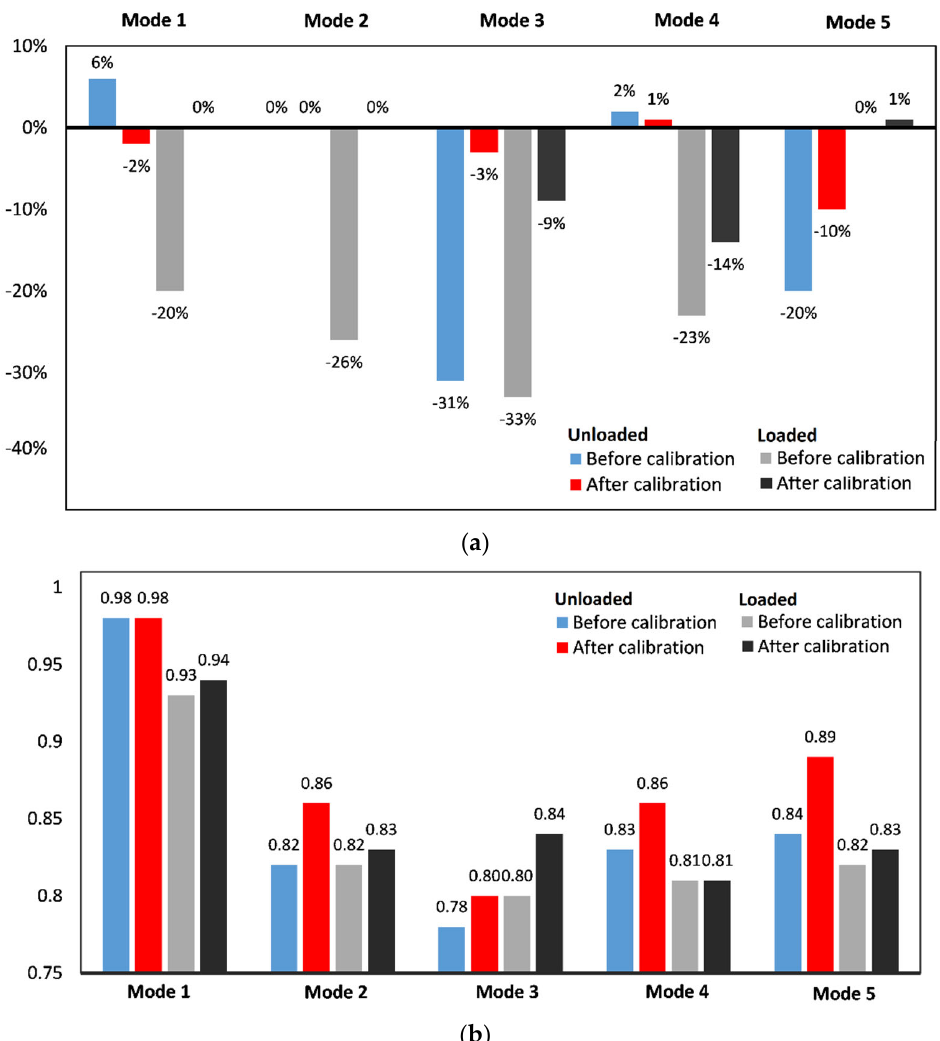
Figure 19. Errors between experimental and numerical modal responses, before and after calibration: ( a ) natural frequencies, ( b ) MAC.